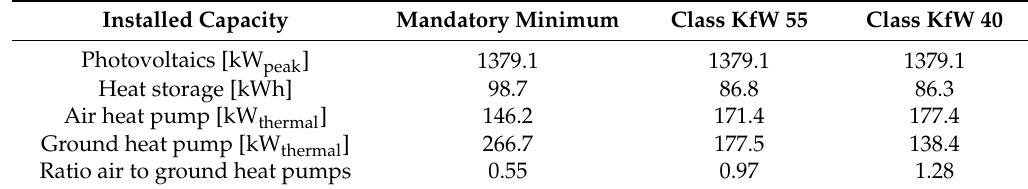
Table 8. Installed optimal capacities for the given settlement for each class.